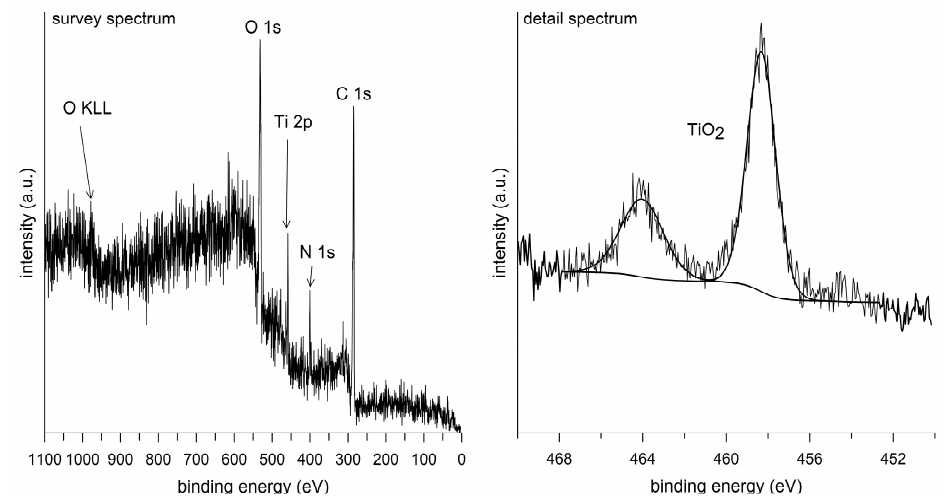
Figure 2. Survey and detail spectra of plasma-sprayed Ti.